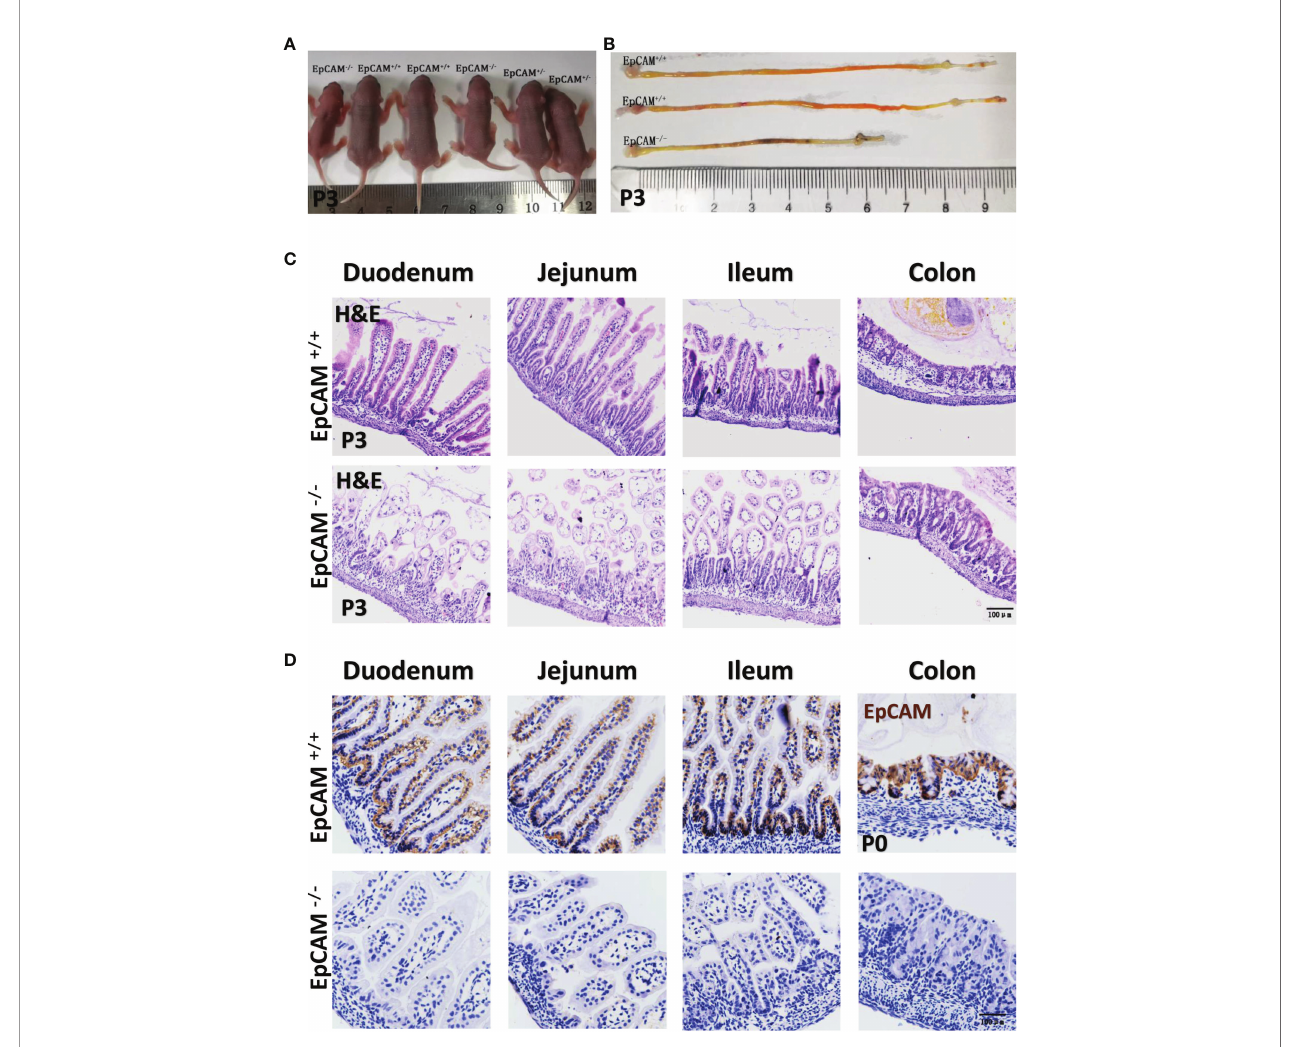
FIGURE 1 | EpCAM de fi ciency caused in fl ammation in the intestines of postnatal mice. (A) A littermate of P3 pups from one pair of EpCAM +/- parental mice. (B) The images of intestines from WT and EpCAM -/- pups at P3 stage. (C) Images of H&E staining of duodenum, jejunum, ileum and colon from WT and EpCAM -/- pups at P3 stage. (D) Images of the immunohistochemical staining of EpCAM in the sections of duodenum, jejunum, ileum and colon from WT and EpCAM -/- pups at P0